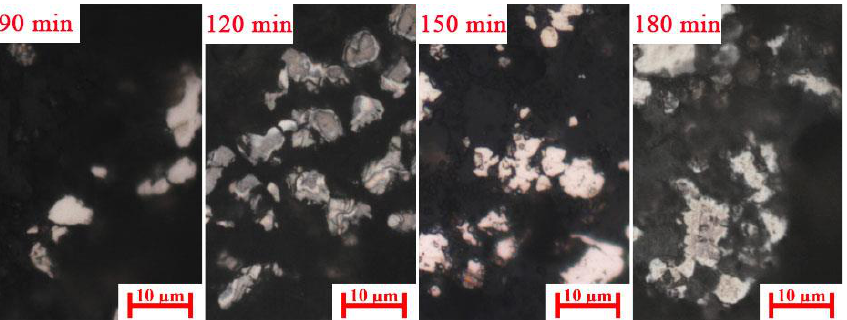
Figure 11. Microstructures of carburized pellet at different carburization times (iron carbide: white).